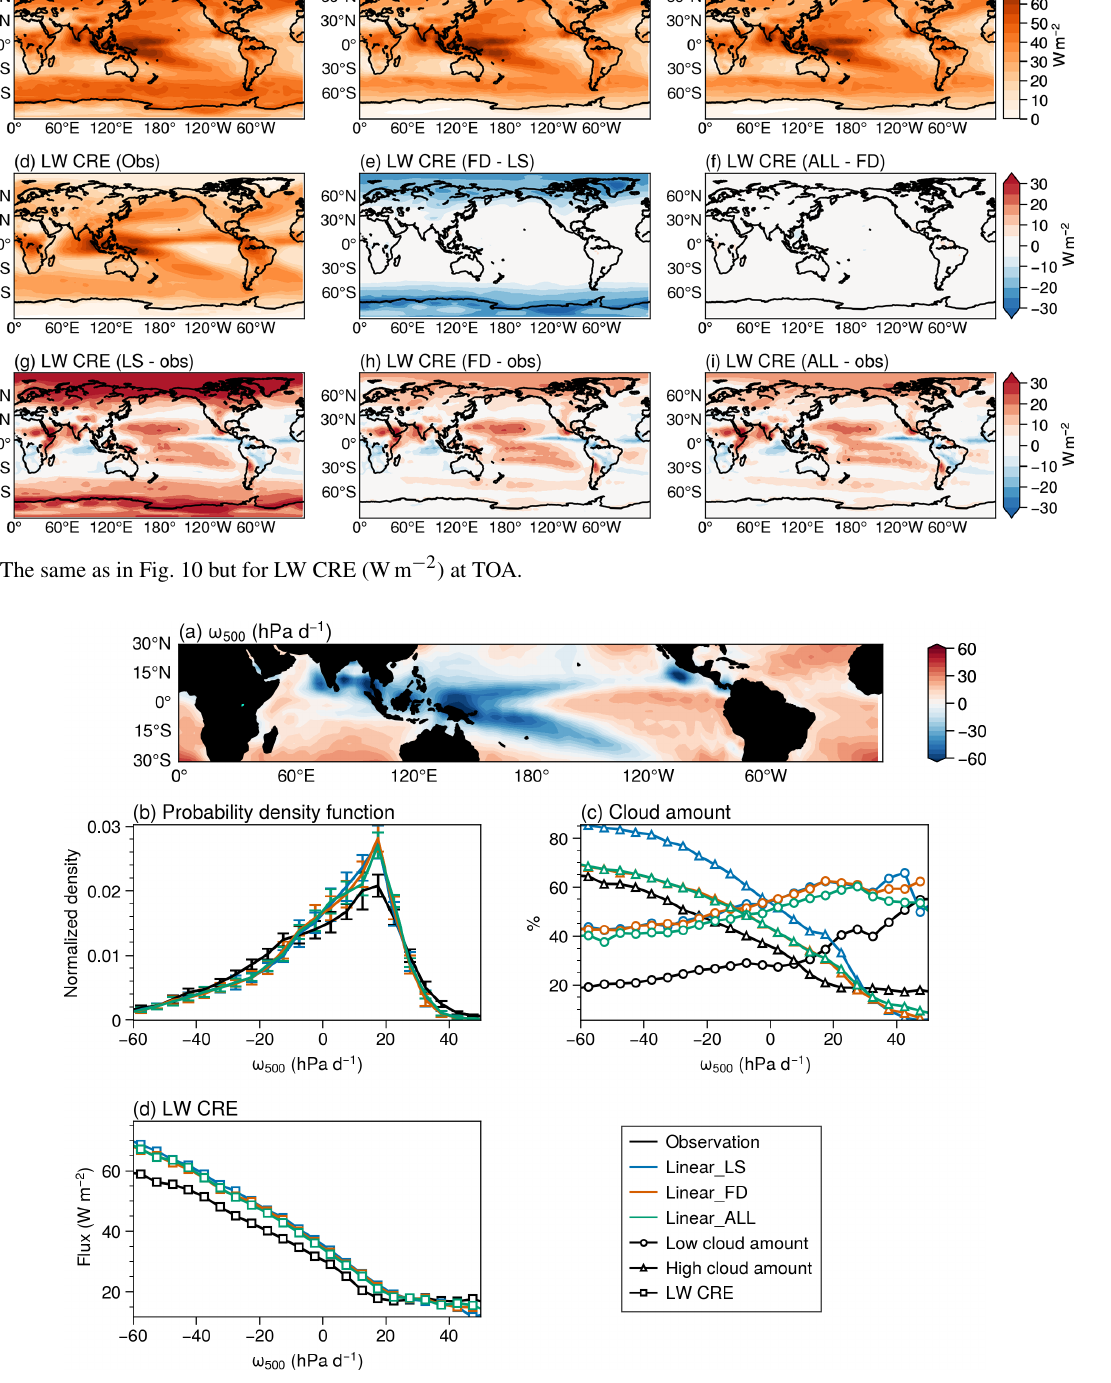
Figure 13. (a) The vertical pressure velocity field at 500hPa ( ω 500 ) over tropical oceans between 30 ◦ S and 30 ◦ N from the linear_LS simulation. (b) The probability density functions (PDFs) of the 500hPa large-scale vertical velocity ( ω 500 ) over the tropical ocean regions defined in (a) , where the vertical bars indicate 1 standard deviation of the annual mean data. (c) The low and high cloud amounts and (d) the TOA LW CRE in different dynamical regimes binned by ω 500 . The 9-year (2007–2015) observed cloud amounts from CALIPSO-GOCCP and the LW CRE from CERES-EBAF are binned by ω 500 from ERA-Interim reanalysis data set (black lines). The results from the LS, FD and ALL simulations with the linear RH scheme are represented by blue, orange and green lines, respectively.